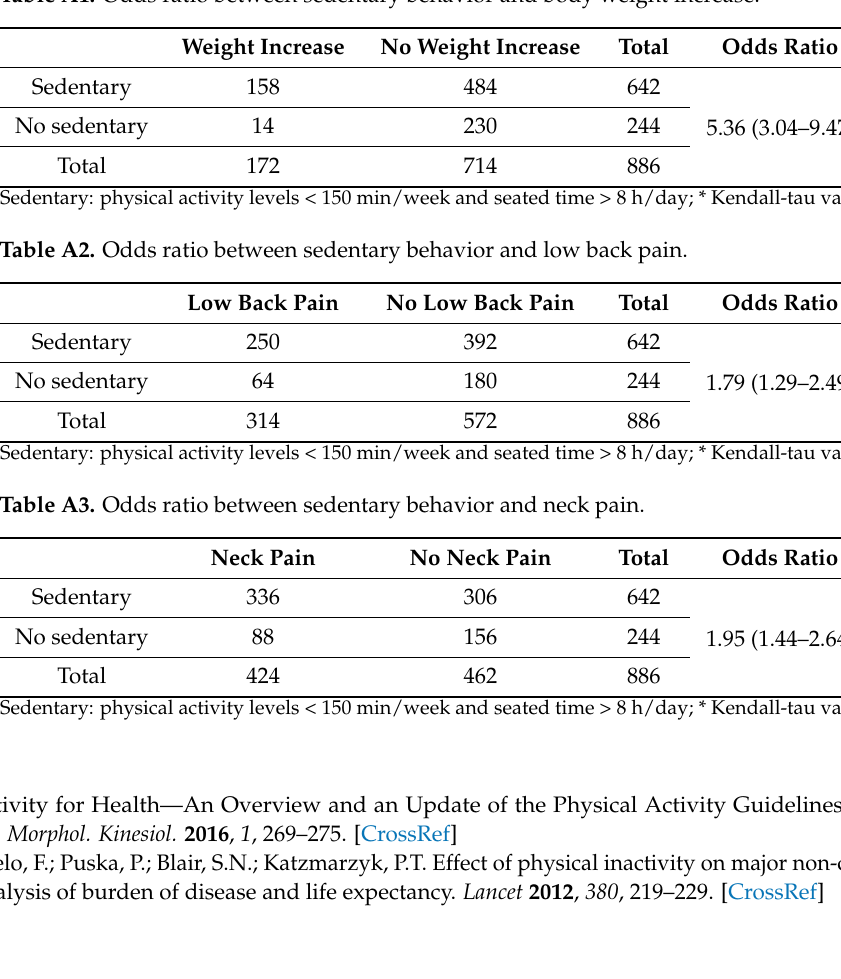
Table A1. Odds ratio between sedentary behavior and body weight increase.